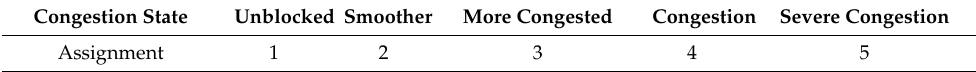
Table 4. Assignment